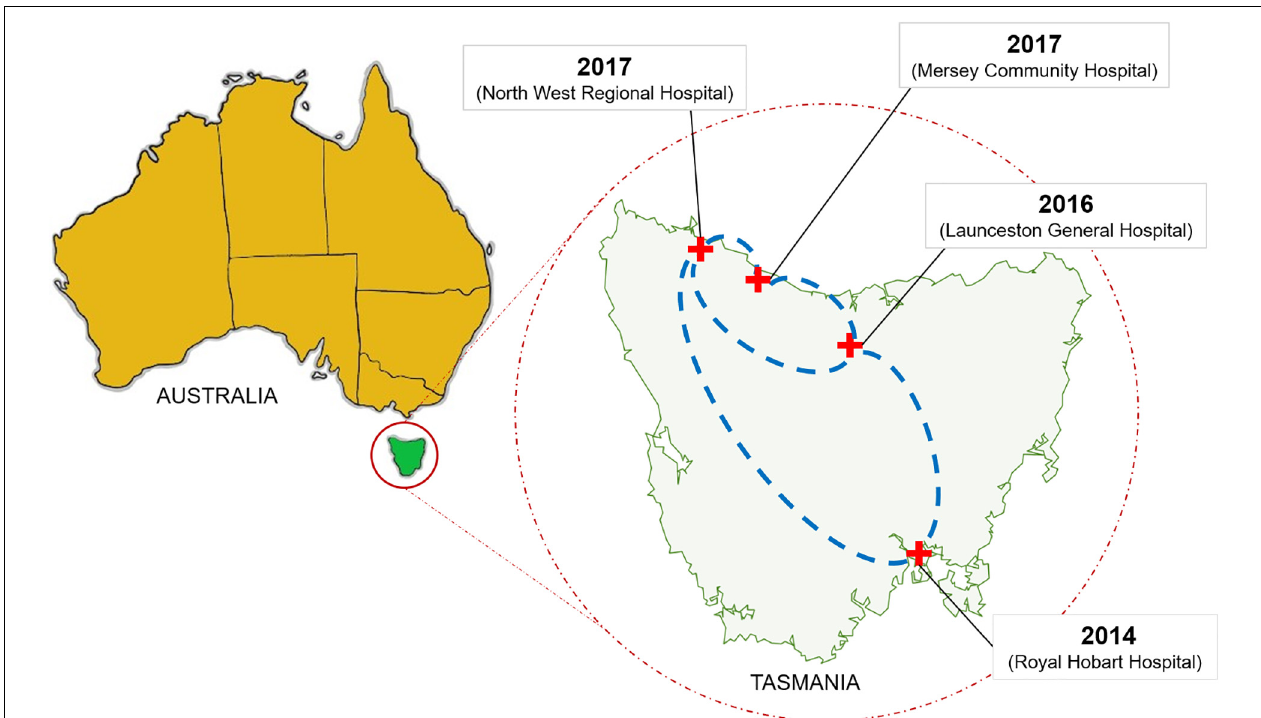
FIGURE 9 | Dissemination of the vanA ST1421 vancomycin-resistant Enterococcus faecium (VREfm) in Tasmania’s public hospital system. The first reported case of ST1421 VREfm in Tasmania occurred at the Royal Hobart Hospital in 2014. Correlation of genomic data with epidemiological data revealed a network in which recently identified sequence type of VREfm (ST1421) emerged in each of the state’s other public